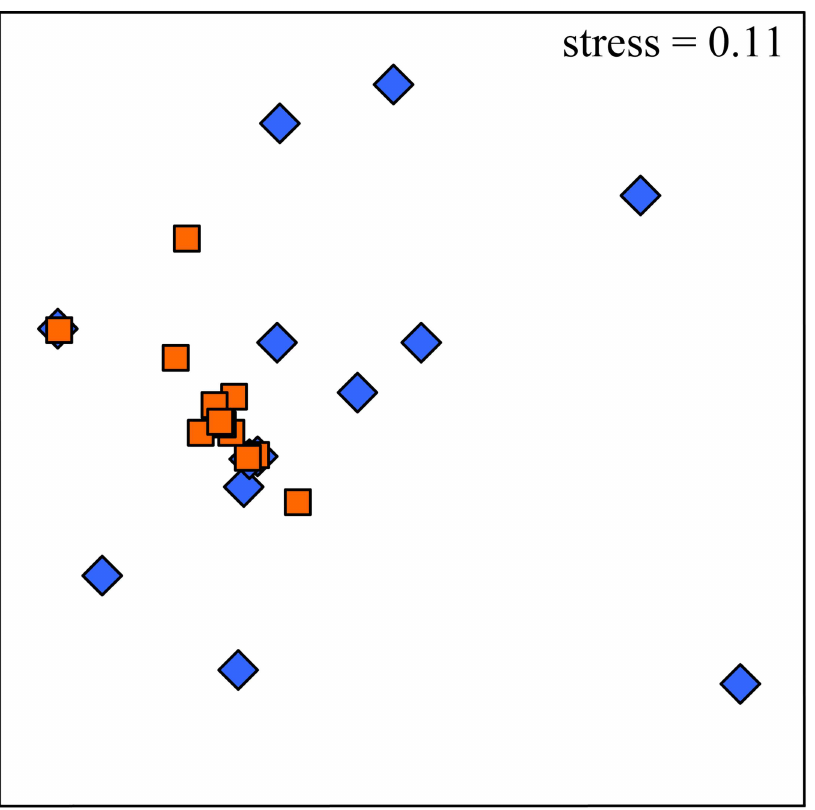
Fig 5. Grazer assemblages differ between areason vs off worm-tubes. nMDS plot of densities of mobile assemblages (grazers) on areas of boulderson top of serpulimorph tube encrustations (orangesquares)and on areas of bouldersoff encrustations (blue diamonds).Data shown are pooledfrom three random sites; n = 5. https://doi.org/10.1371/journal.pone.0176952.g005 in rock-pools [51] or humid crevice environments [52], or when rain occurs [53]. This study has described, for the first time to my knowledge, Ulva spp. apparently shifting its niche and colonising the upper-shore via provision of biogenic habitat by tubeworms. The pattern was striking, with no instances of any Ulva being detected on any co-occurring boulders, while up to 61% occurred on boulders with tubeworms. This effect appeared to be driven by facilitation